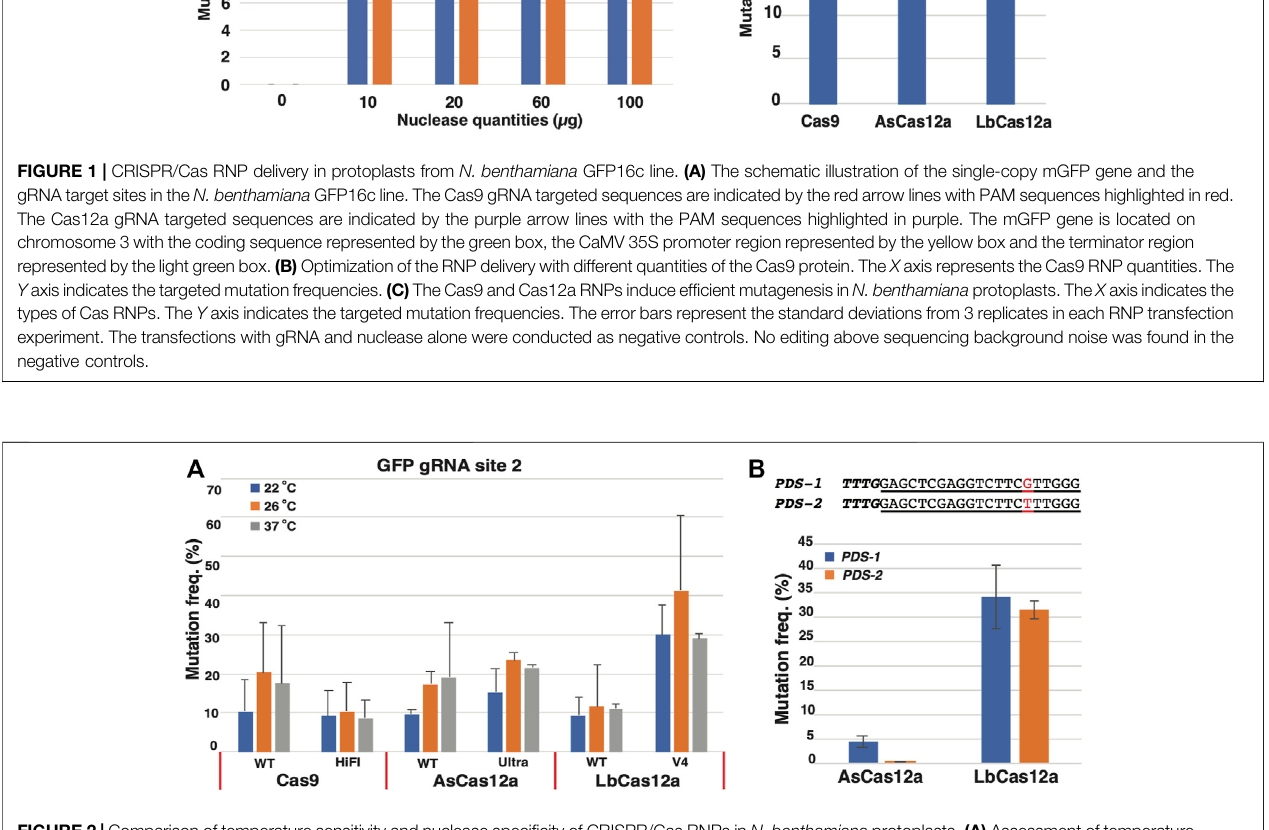
FIGURE 2 | Comparison of temperature sensitivity and nuclease speci fi city of CRISPR/Cas RNPs in N. benthamiana protoplasts. (A) Assessment of temperature sensitivity for the Cas RNPs. Mutation frequencies ( Y axis) induced by various Cas9 and Cas12a RNPs ( X axis) under three different temperatures, 22 ° C (blue), 26 ° C (orange) and 37 ° C (grey), respectively. (B) Assessment of sequence speci fi city for AsCas12a and LbCas12a RNPs. The PDS 1 and PDS 2 targeted sequences is shown with the 1 bp mismatch highlighted in red. Mutation frequencies ( Y axis) induced by AsCas12a_Ultra and LbCas12a_V4 RNPs ( X axis) is indicated for each